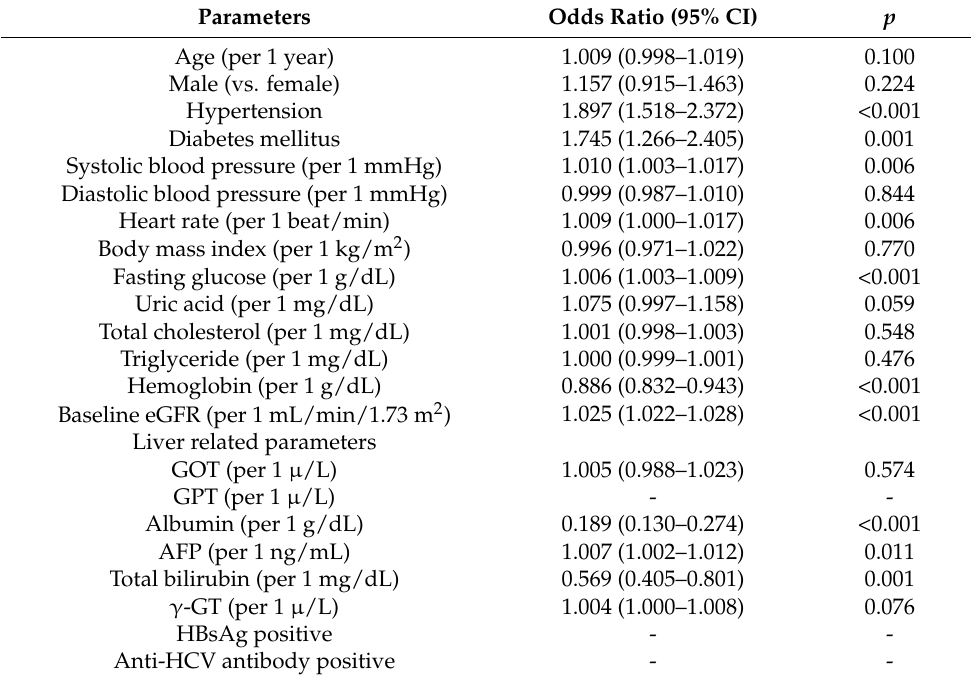
Values expressed as odds ratio and 95% confidence interval (CI). Abbreviations are the same as in Table